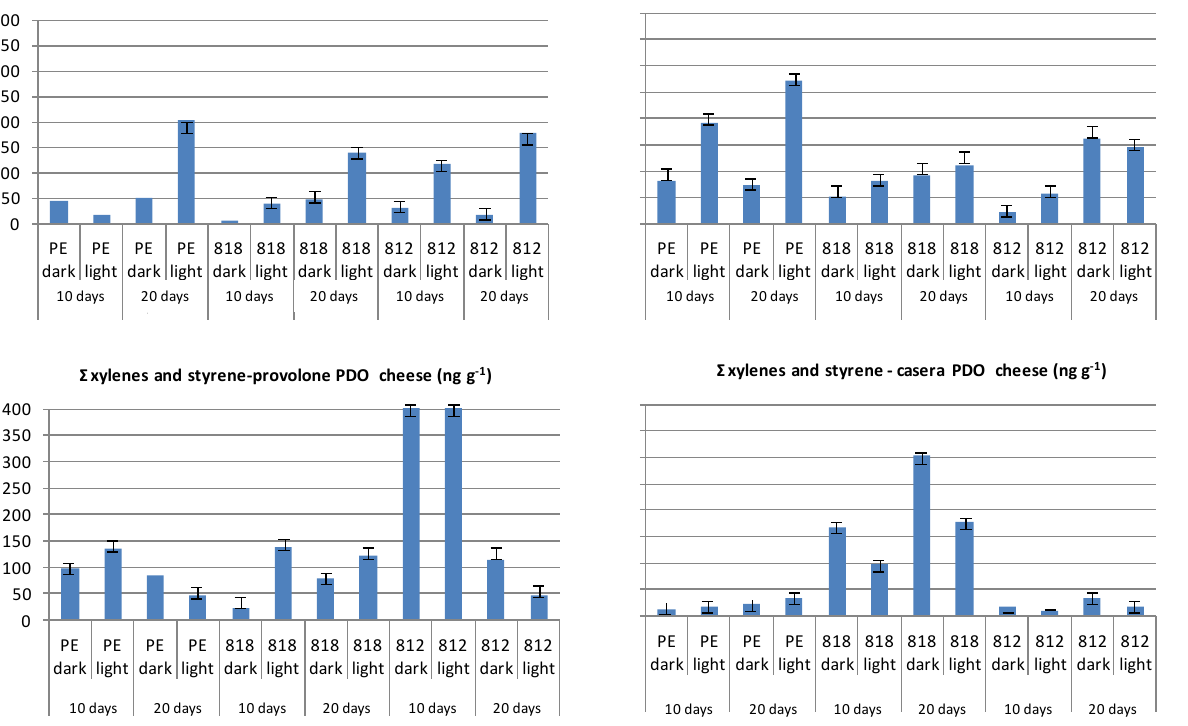
Figure 7. Levels of xylenes (Σ of p - m - o xylene) and styrene in PDO cheeses wrapped in different films and stored refrigerated for 10 and 20 days in the dark or under fluorescent light (data expressed as ng·g −1 of